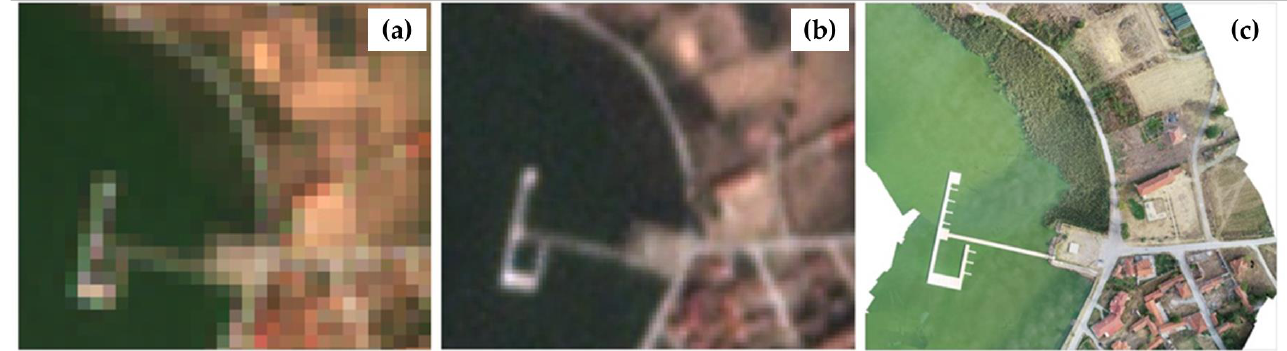
Figure 12. Part of lake Zazari (Northern Greece) showing the differences in spatial resolution of imagery data as captured by ( a ) Sentinel -2 (10 m), ( b ) nanosatellite (3 m), and ( c ) UAV (<0.5 m).